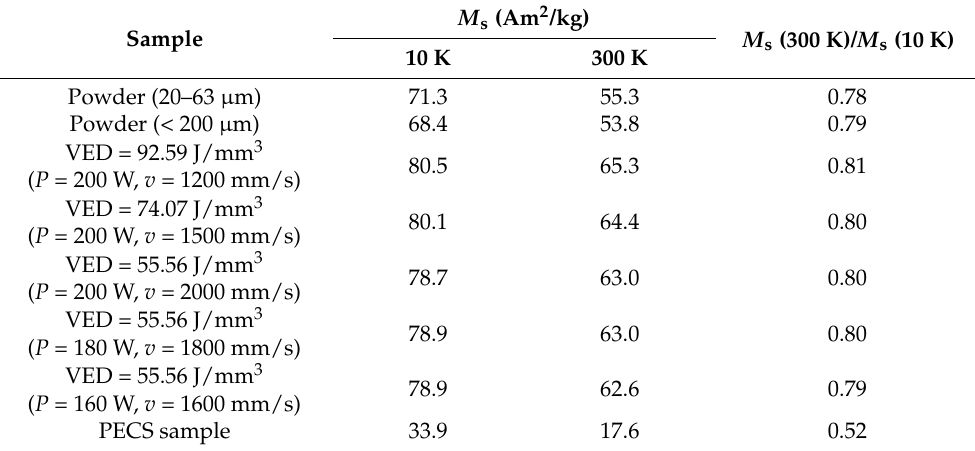
Figure 13. Magnetization ( M - H ) curves at ( a ) 10 K and ( b ) 300 K for original powder, as-built AlCoCr 0.75 Cu 0.5 FeNi specimens, and reference PECS sample. Table 4. The saturation magnetization at 9 T of raw powder, LPBF-built AlCoCr0.75Cu0.5FeNi specimens, and reference PECS sample tested at 10 and 300 K.